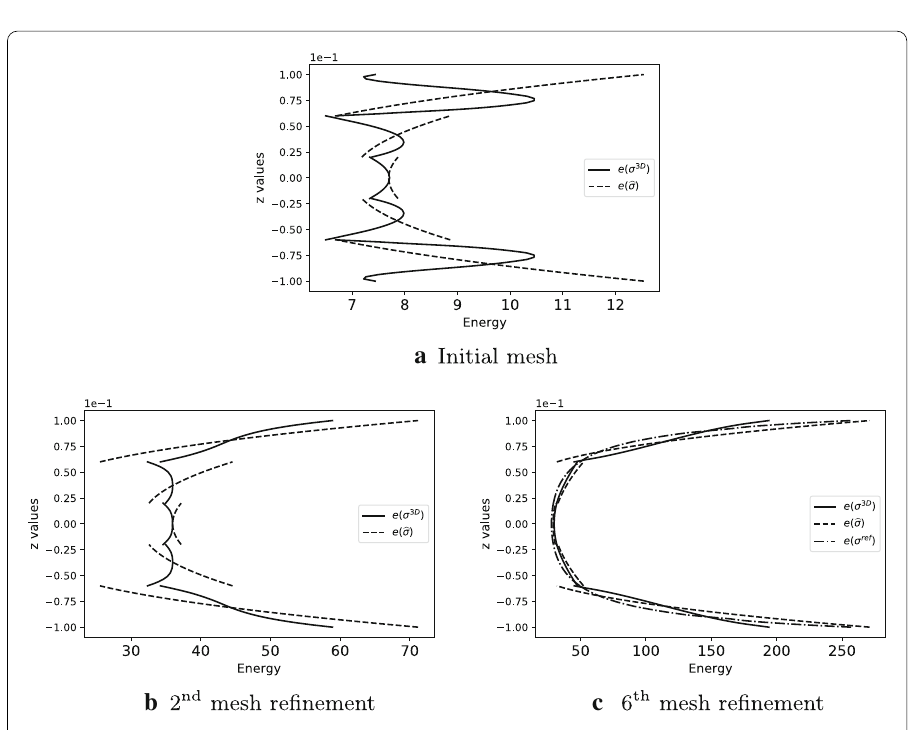
Fig. 5 Energy densities across the plate thickness computed for σ 3 D , (cid:13) σ and σ ref at the plate edge for n = 5